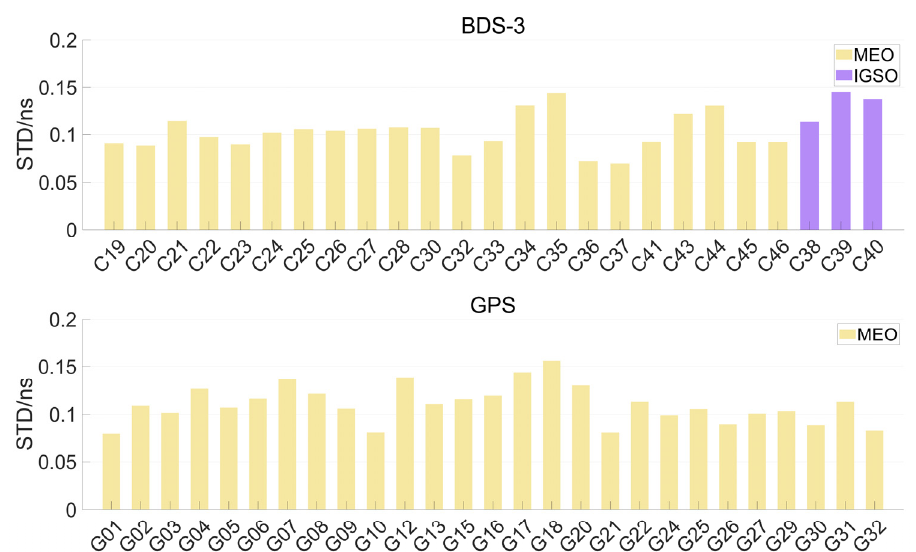
Figure 9. STD of the BDS-3 and GPS satellite clock offset recovered with the PPP-B2b signals using the GBM orbit products as a reference during DOY 168–198 in 2022.